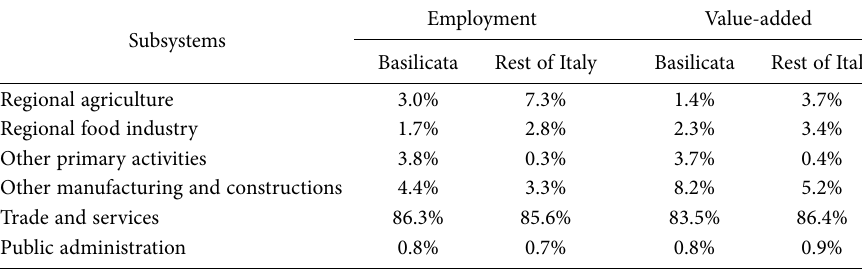
Table 8. Final demand composition of the restaurant and accommodation